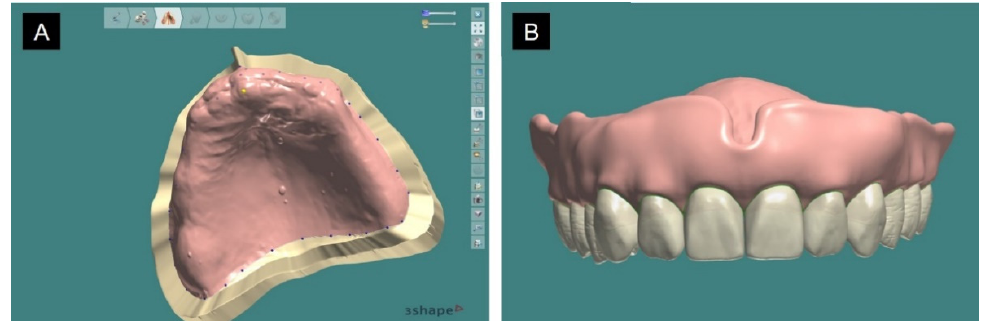
Figure 6. Trial denture designed using the denture module of the computer-aided design software with the selected vertical dimension. ( A ) Digital edentulous model. ( B ) Designed trial denture.